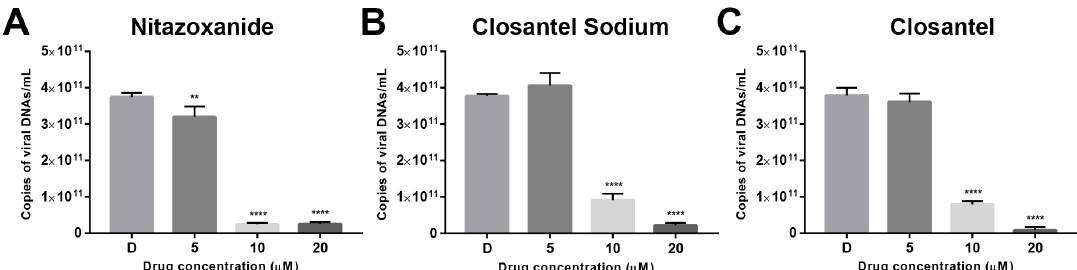
Figure 3. The antiviral e ff ects of the identified drugs were analyzed by quantification of viral DNAs. F81 cells seeded in 6-well plates were pretreated with 5 µ M, 10 µ M, or 20 µ M of Nitazoxanide ( A ), Closantel Sodium ( B ), or Closantel ( C ) before CPV infection. Total DNA was extracted at 40 hpi from whole cell lysates. The absolute number of copies of the VP2 gene in the cells was determined according to the generated standard curve. Error bars represent standard errors from three independent experiments. Statistical analysis was normalized to Control (0.1% DMSO-treated cells, marked as D in the figure) and carried out using one-way ANOVA and Dunnett’s multiple comparisons test. * p < 0.05; ** p < 0.01; *** p < 0.005; **** p < 0.001.